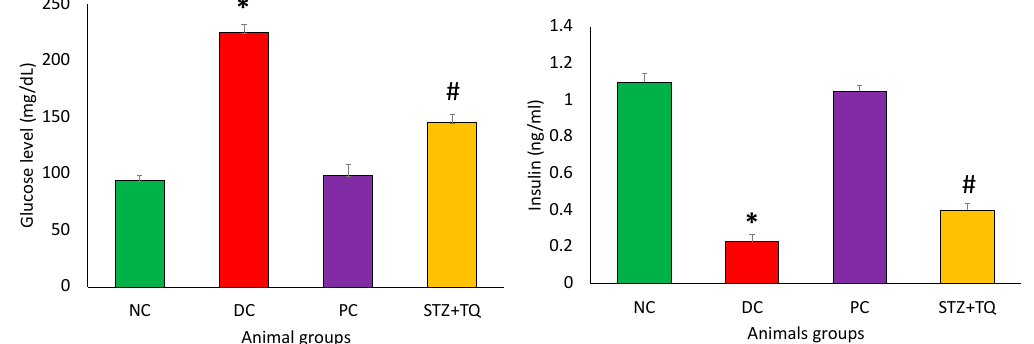
Figure 2. The level of blood glucose and insulin change in different groups of rats after 8 weeks of continues treatment.